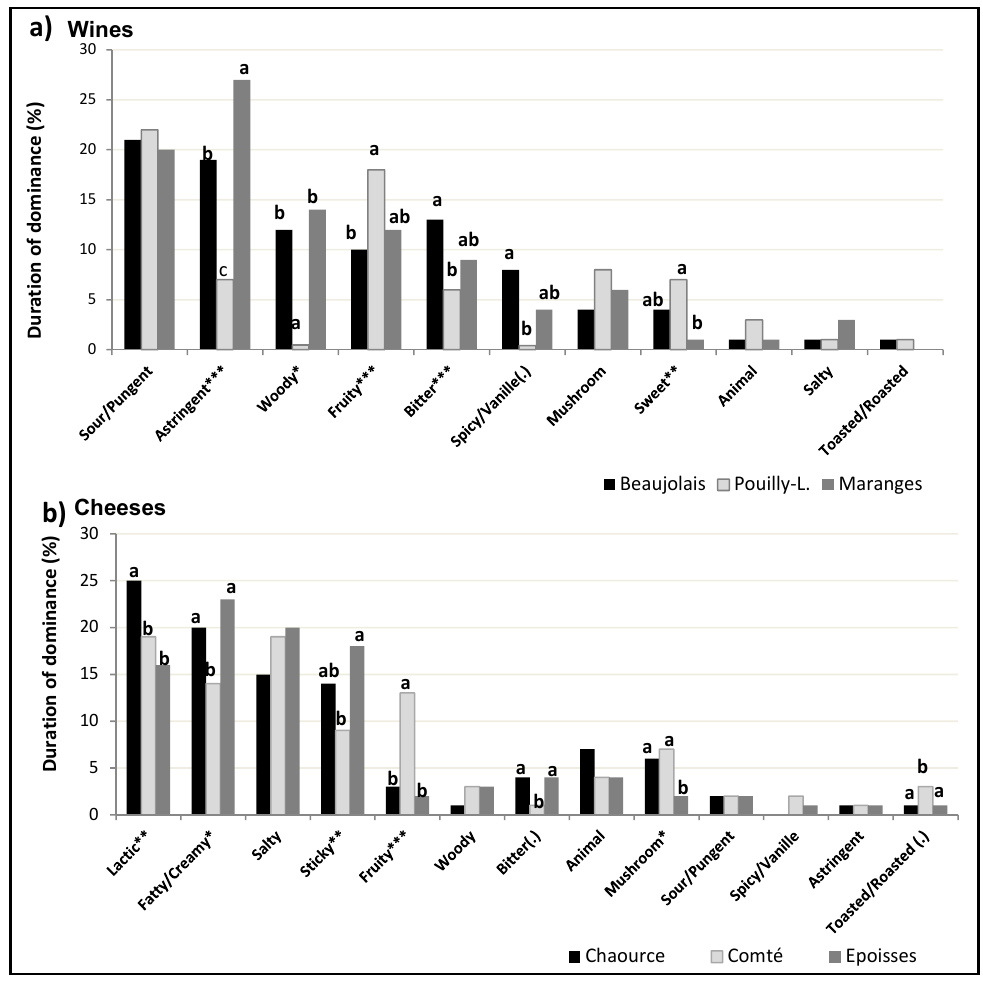
Figure 2. ( a , b ) Description of wine and cheeses in terms of duration of dominance (% of total standardized duration) of the different attributes. Significance levels: ( . ) 10%, * 5%, ** 1%, *** 0.1%. Different letters indicate significant differences according to a LSD test.